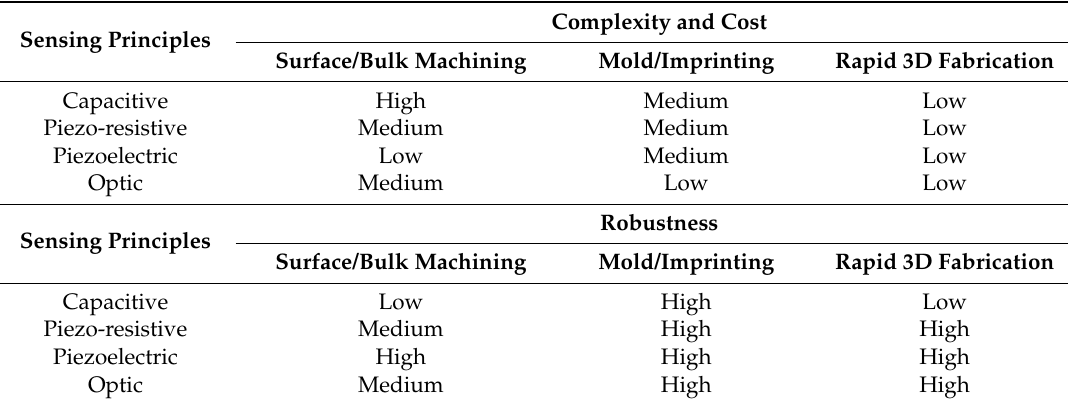
Table 3. Fabrication methods for different types of tactile